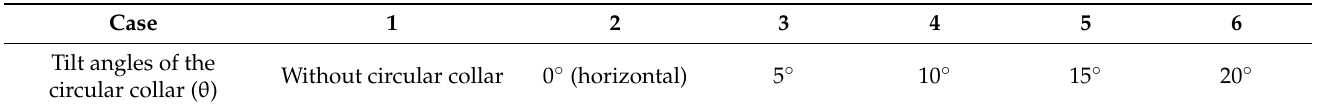
Table 2. Parameters of each case.